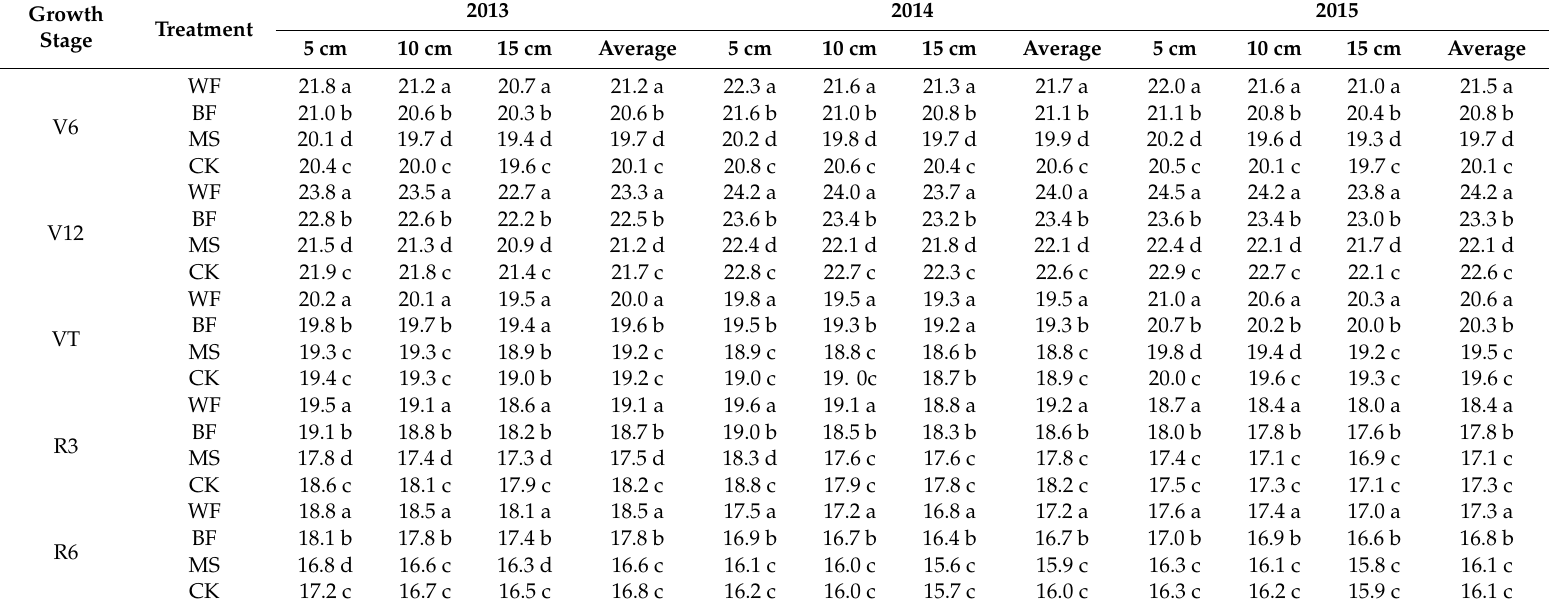
Table 3. E ff ects of di ff erent mulching materials on soil temperatures ( ◦ C) at di ff erent growth periods of maize. Growth